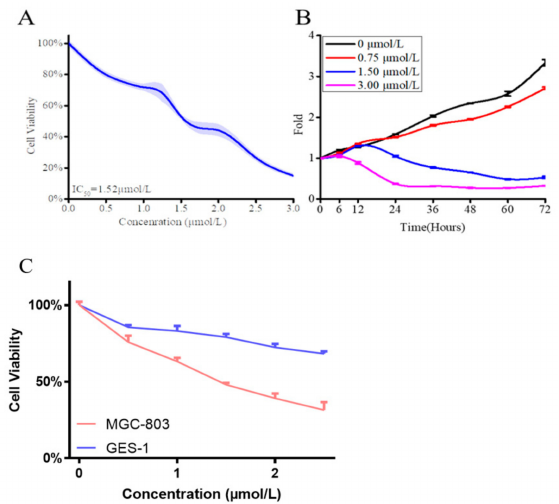
Figure 4. ( A – C ) MGC-803 cells inhibition activity of compound 13e in vivo. ( A ) Cell viabilities of MGC-803 cells, MGC-803 cells were treated with indicated concentrations of compound 13e for 48 h; ( B ) Growth curves of MGC-803 cells after the treatment with indicated concentrations of compound 13e for di ff erent hours. ( C ) Cell viabilities of MGC-803 cells and GES-1 cells, cells were treated with indicated concentrations of compound 13e for 48 h. The results shown were representative of three independent experiments.